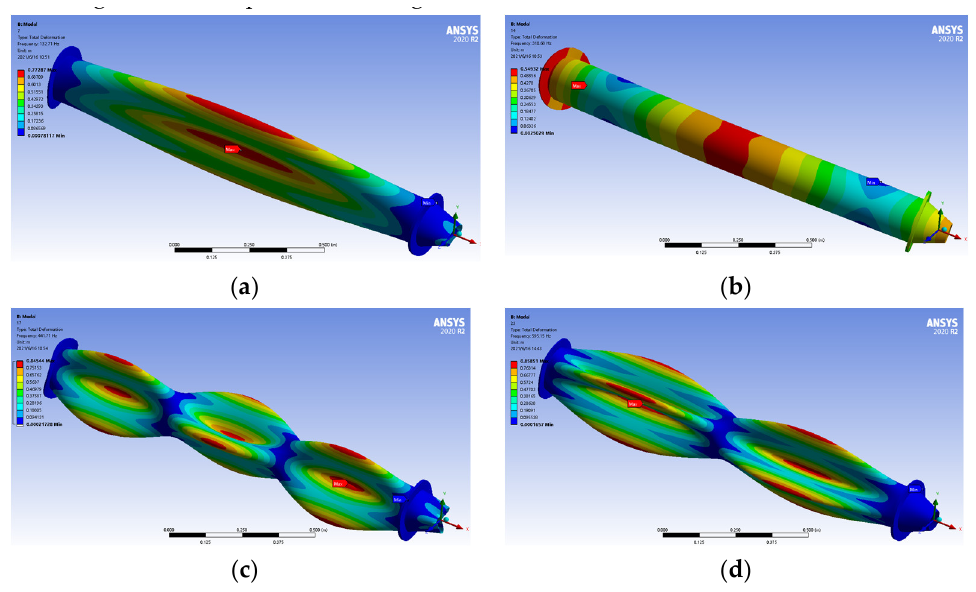
Figure 13. The first four-order vibration modes of the shell model, ( a ) 1st Order vibration modes, ( b ) 2nd Order vibration modes, ( c ) 3rd Order vibration modes and ( d ) 4th Order vibration modes.